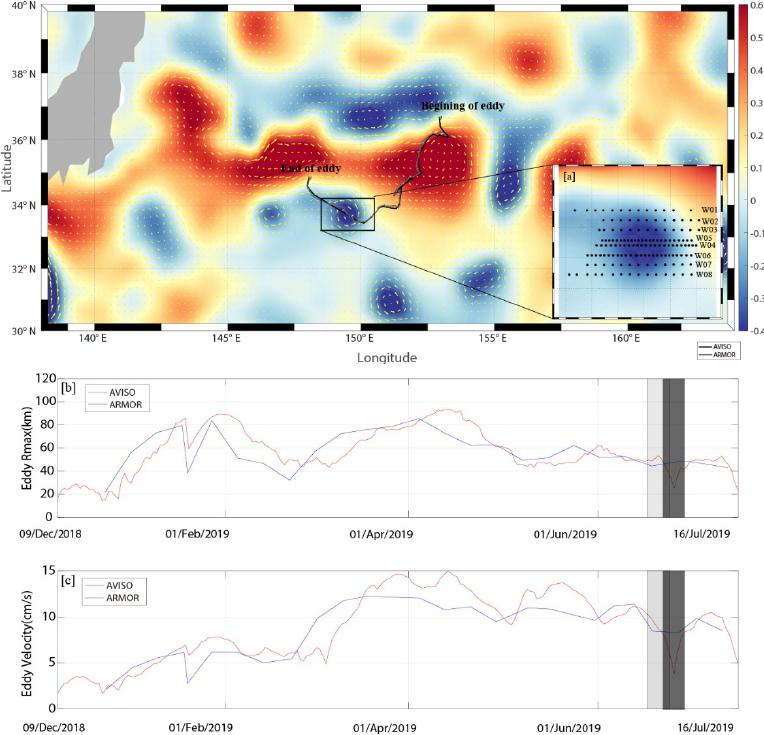
Figure 1. ( a ) Mesoscale eddy trajectory and distribution of observation stations: ( b ) Eddy radius; ( c ) Eddy velocity. Note: ( a ) The color shading shows the average sea level anomaly distribution in KER during in situ period (14–22 June 2019). The yellow arrows were the geostrophic flow arrow; the light gray shades in ( b ) and ( c ) indicate 14–22 June 2019, and the dark shading indicates 19–26 June. During our observation period, the eddy data were sampled using the following in-